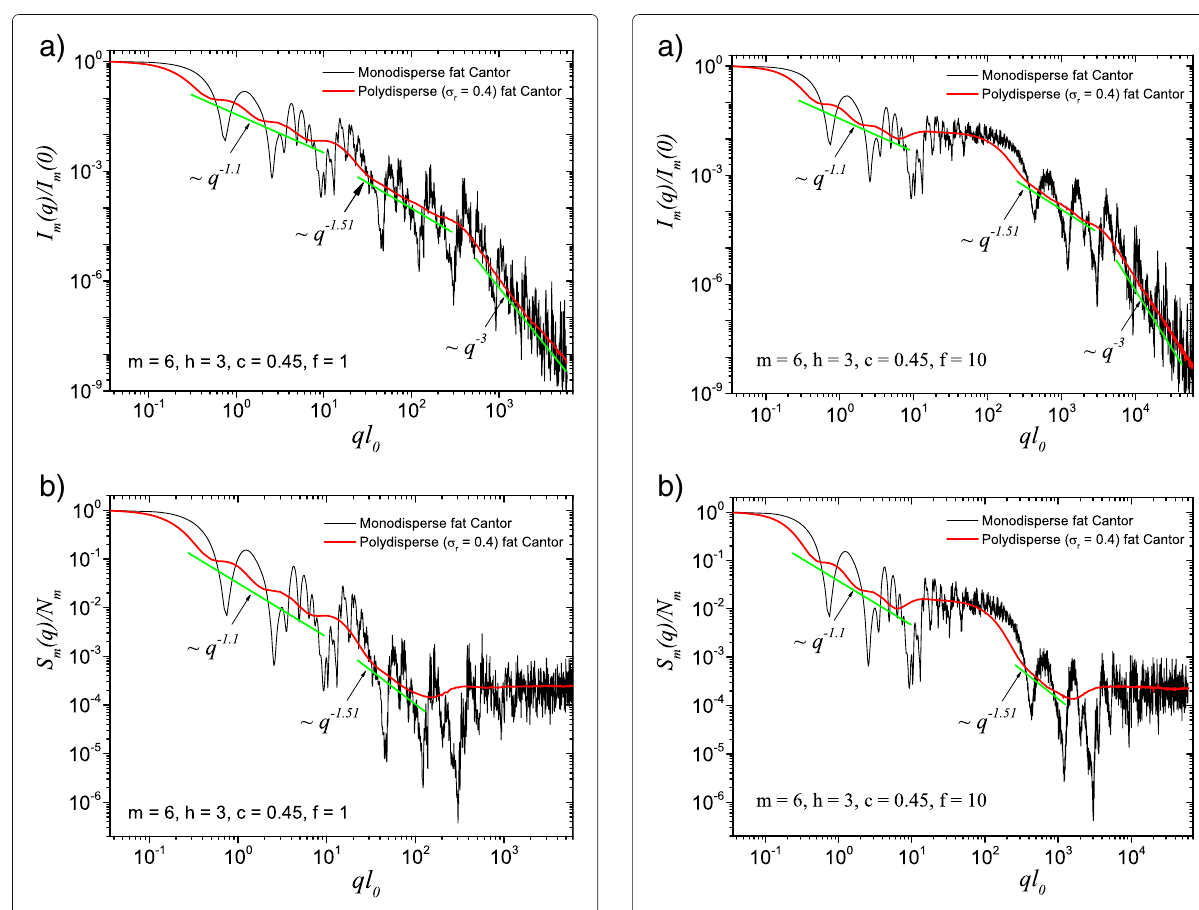
units leads to the choice of f = 10 in Fig. 4.